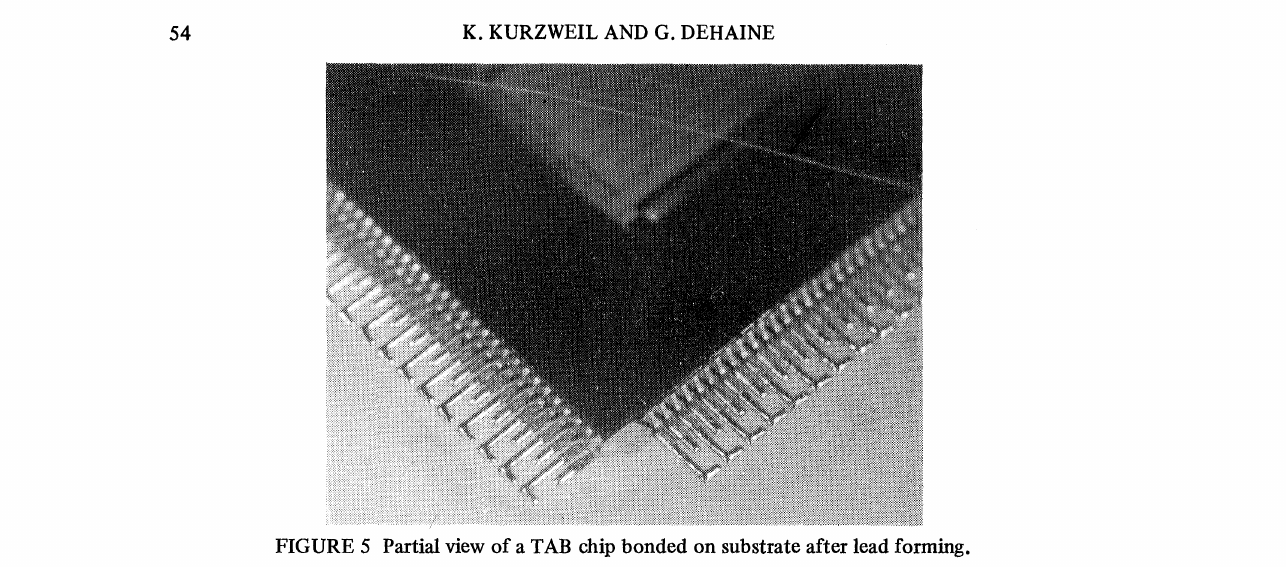
FIGURE 5 Partial view of a TAB chip bonded on substrate after lead forming.